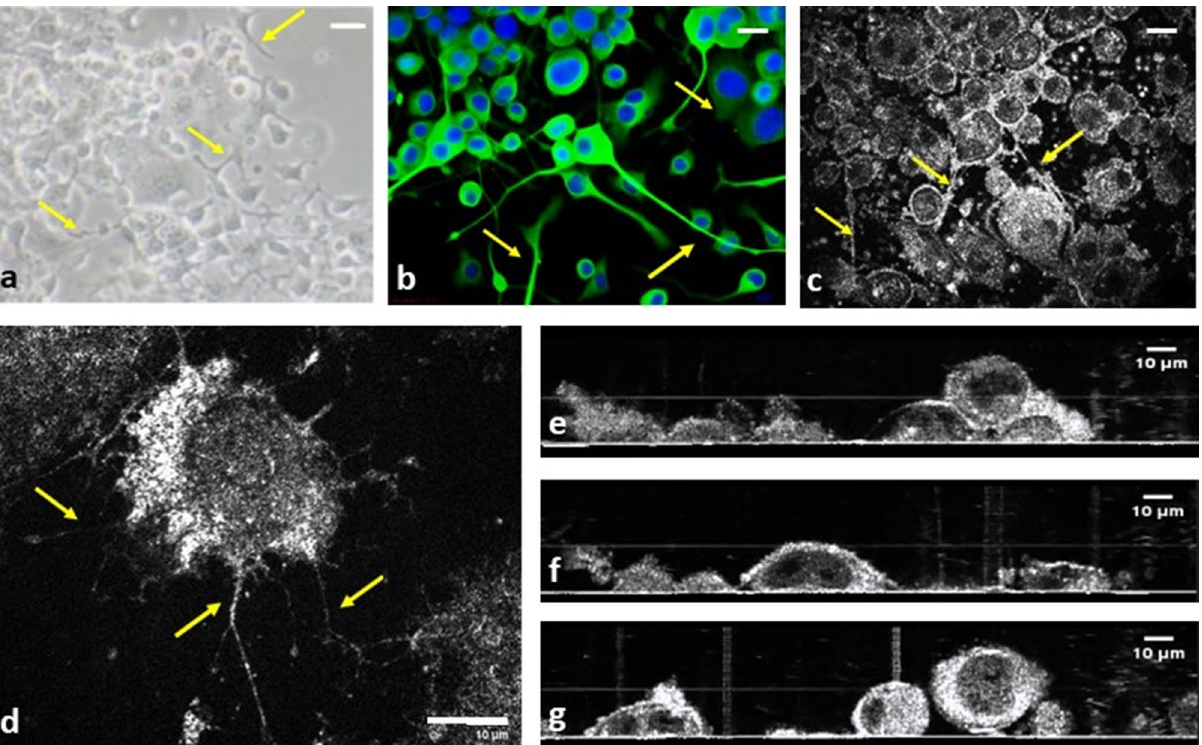
Figure 1. Histocytochemical and FF-OCT images of neuron cells (N2A). ( a ) Phase contrast inverted microscopy revealed the growth patterns of neuron cells. ( b ) Immunocytochemical staining demonstrated a typical growth pattern of neuron cells with long neuron processes. (Green: beta-III tubulin; Blue: Hoechst 33,258 for nucleus). ( c , d ) FF-OCT en face images of neuron cells. ( b–d ) Yellow arrows indicated long neuron processes. ( e–g ) Cross-sectional 2D FF-OCT images of neuron cells. The morphology and size of the nucleus and nucleolus in each cell could easily be traced, and more than 1 nucleolus were identified in certain single-cell bodies. Scale bar = 10 µm.